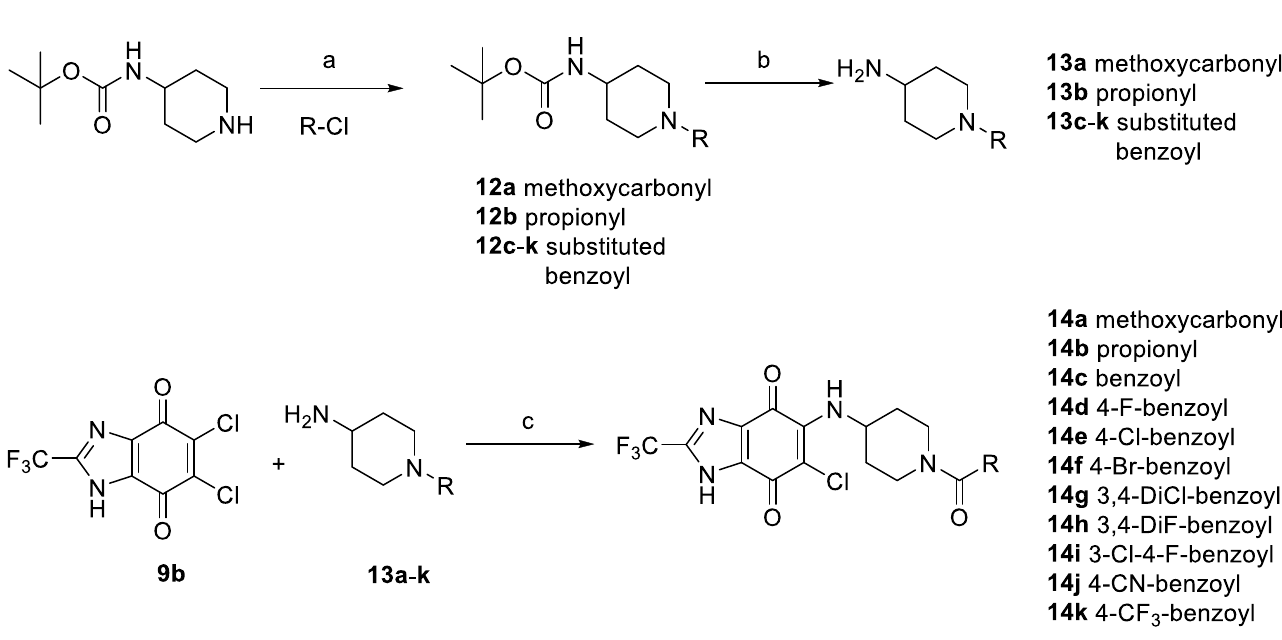
Table 3. The antagonistic activity profile of various piperidine derivatives.